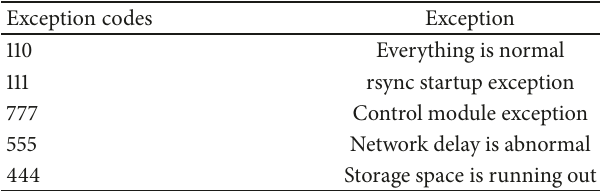
Table 3: Exception code correspondence